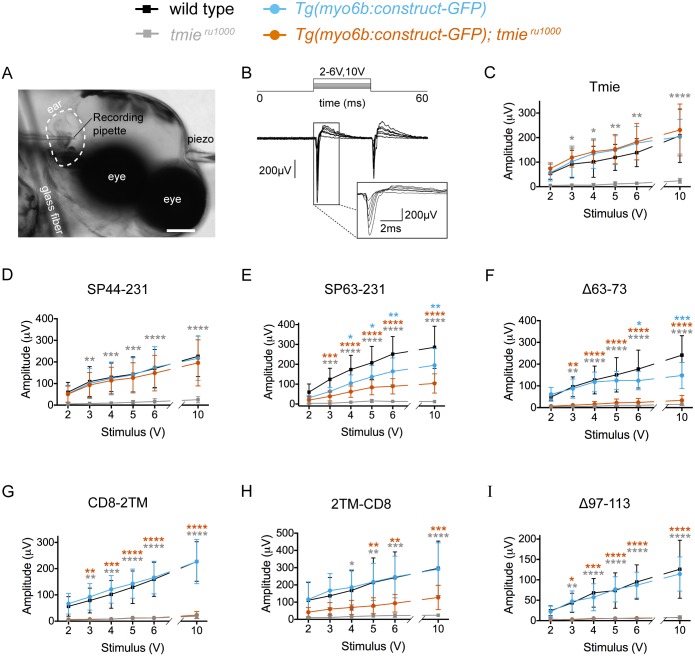
The second transmembrane and adjacent regions of Tmie are required for inner ear microphonics.(A) A DIC image of a 3 dpf larva, anesthetized and pinned (glass fiber) for inner ear recordings. Shown are a probe attached to a piezo actuator (piezo) pressed against the head and a recording pipette pierced into the inner ear. Scale bar is 100μm. (B) Example traces from a wild type larva. A step stimulus was applied with a 20 ms duration; 200 traces were averaged for each of the six piezo driver voltages: 2V, 3V, 4V, 5V, 6V, and 10V. Gray box: magnification of the onset of response in individual traces. (C-I) Plots of the mean amplitude of the response peak ± SD as a function of the stimulus intensity of the driver voltage. We used the stimulation protocol explained in B to obtain responses from larvae expressing one of our transgenic tmie constructs, as labeled. Statistical significance was determined by two-way ANOVA comparing all groups to wild type non-transgenic siblings, n ≥ 5, *p < 0.05, **p < 0.01, ***p < 0.001, ****p < 0.0001.